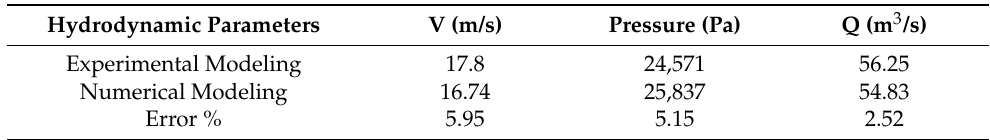
Table 1. Comparison of validation and accuracy results and numerical model calibration for hydro- dynamic parameters.